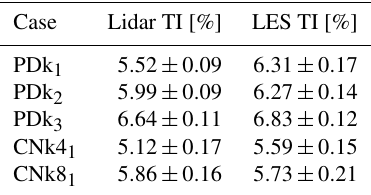
Table 3. Turbulence intensity (TI) comparison of validation cases, averaged over the rotor area. Error estimates represent 95% confi- dence interval and are calculated using the block bootstrap method with block length of 600 and 1000 bootstrap iterations.